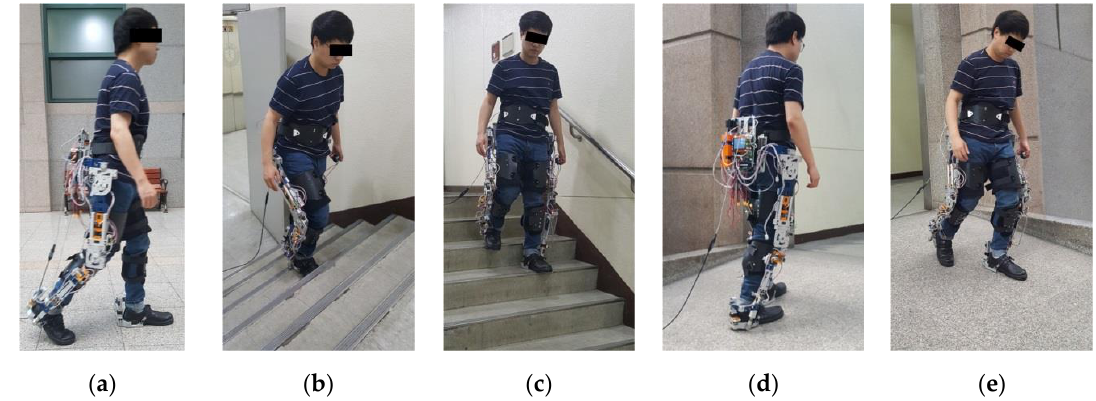
Figure 20. Five types of ambulation tests: (( a ) level walk (LW), ( b ) stair ascent (SA), ( c ) stair descent (SD), ( d ) ramp ascent (RA), and ( e ) ramp descent (RD)) on three different terrains for performance validation of the proposed method. Ramp ascent and descent were conducted on three ramps with different slopes to validate the performance of the slope estimation. Table 3. Demographic characteristics of the